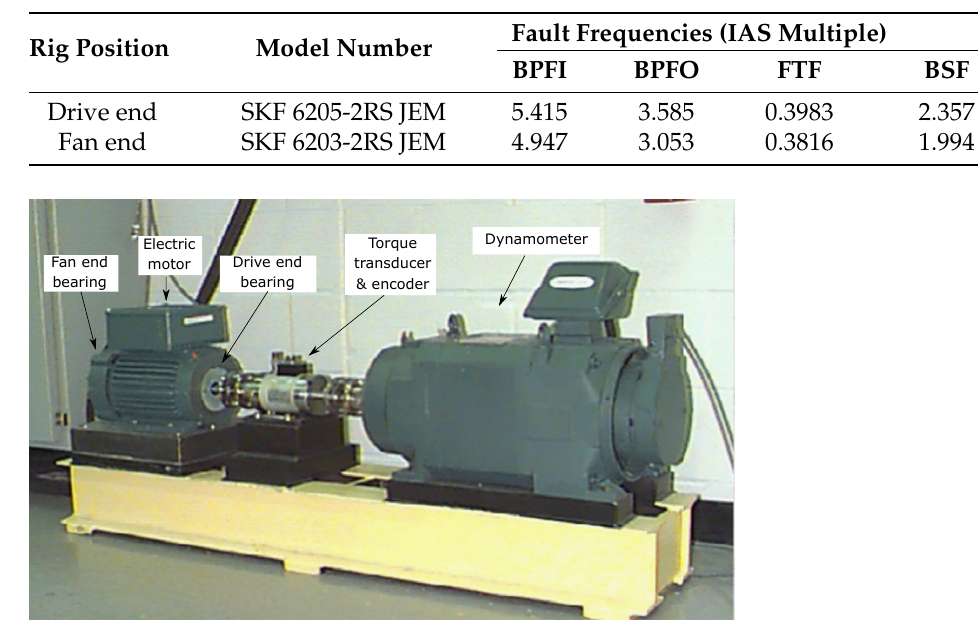
Table 4. Bearing fault frequencies for the test rig.